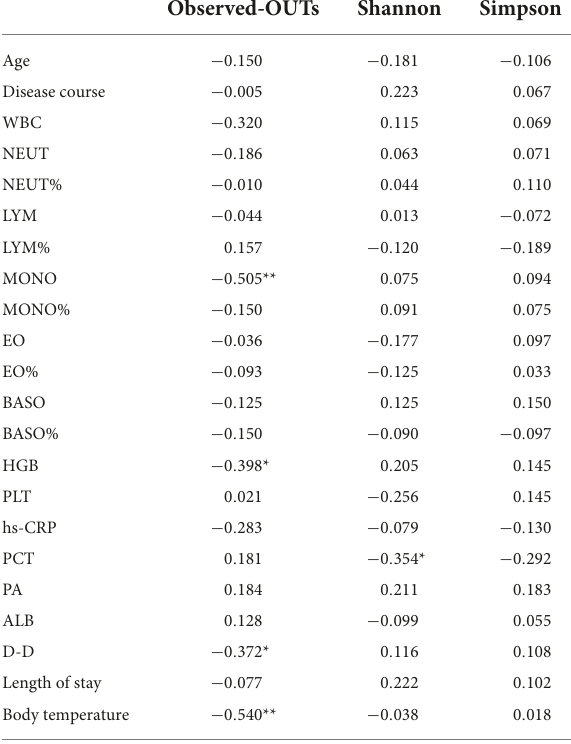
TABLE 3 Correlation analysis of alpha diversity of the airway microflora and clinical indicators in acute exacerbation of chronic obstructive pulmonary disease (AECOPD) group (R correlation coefficient).